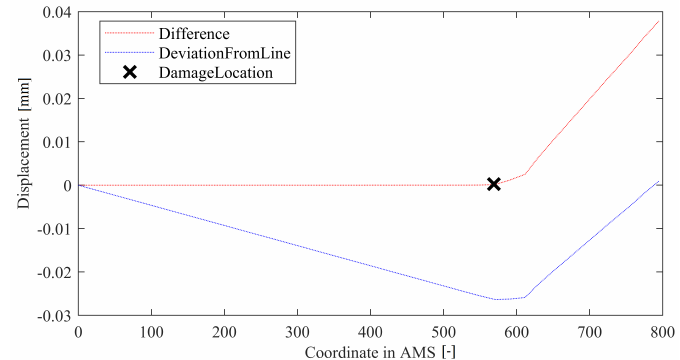
Figure 8. Example of operation of the LD method.